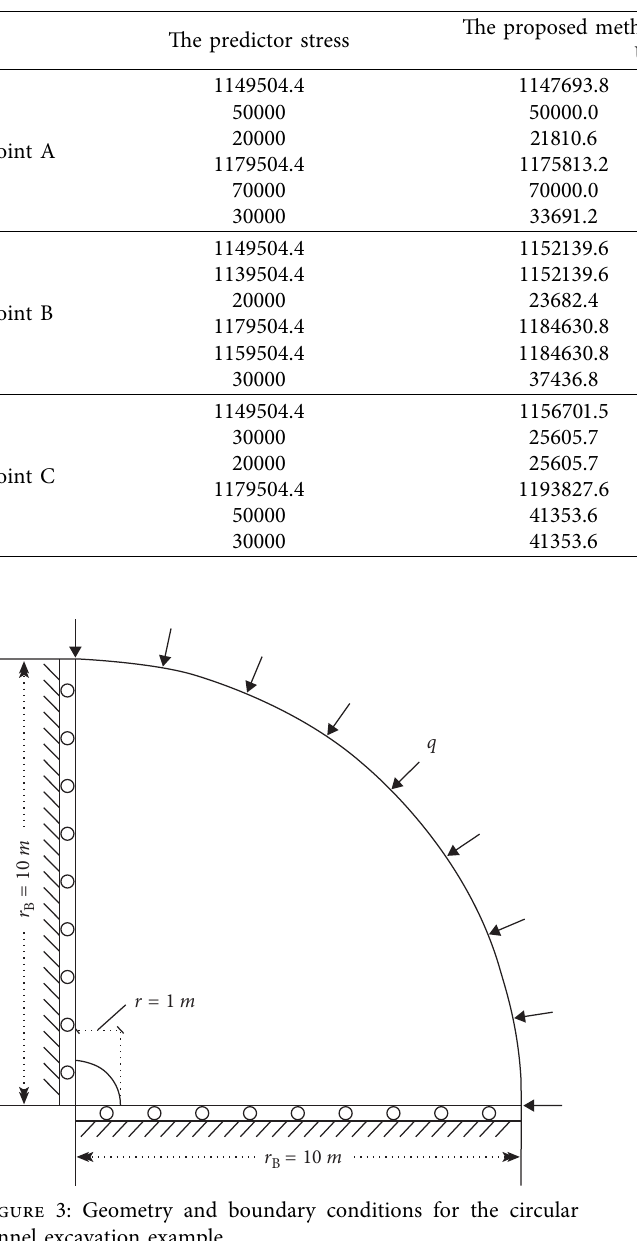
Table 2: The values of the updated stress obtained by the proposed method and Clausen’s method and the relative errors (nonassociated case).